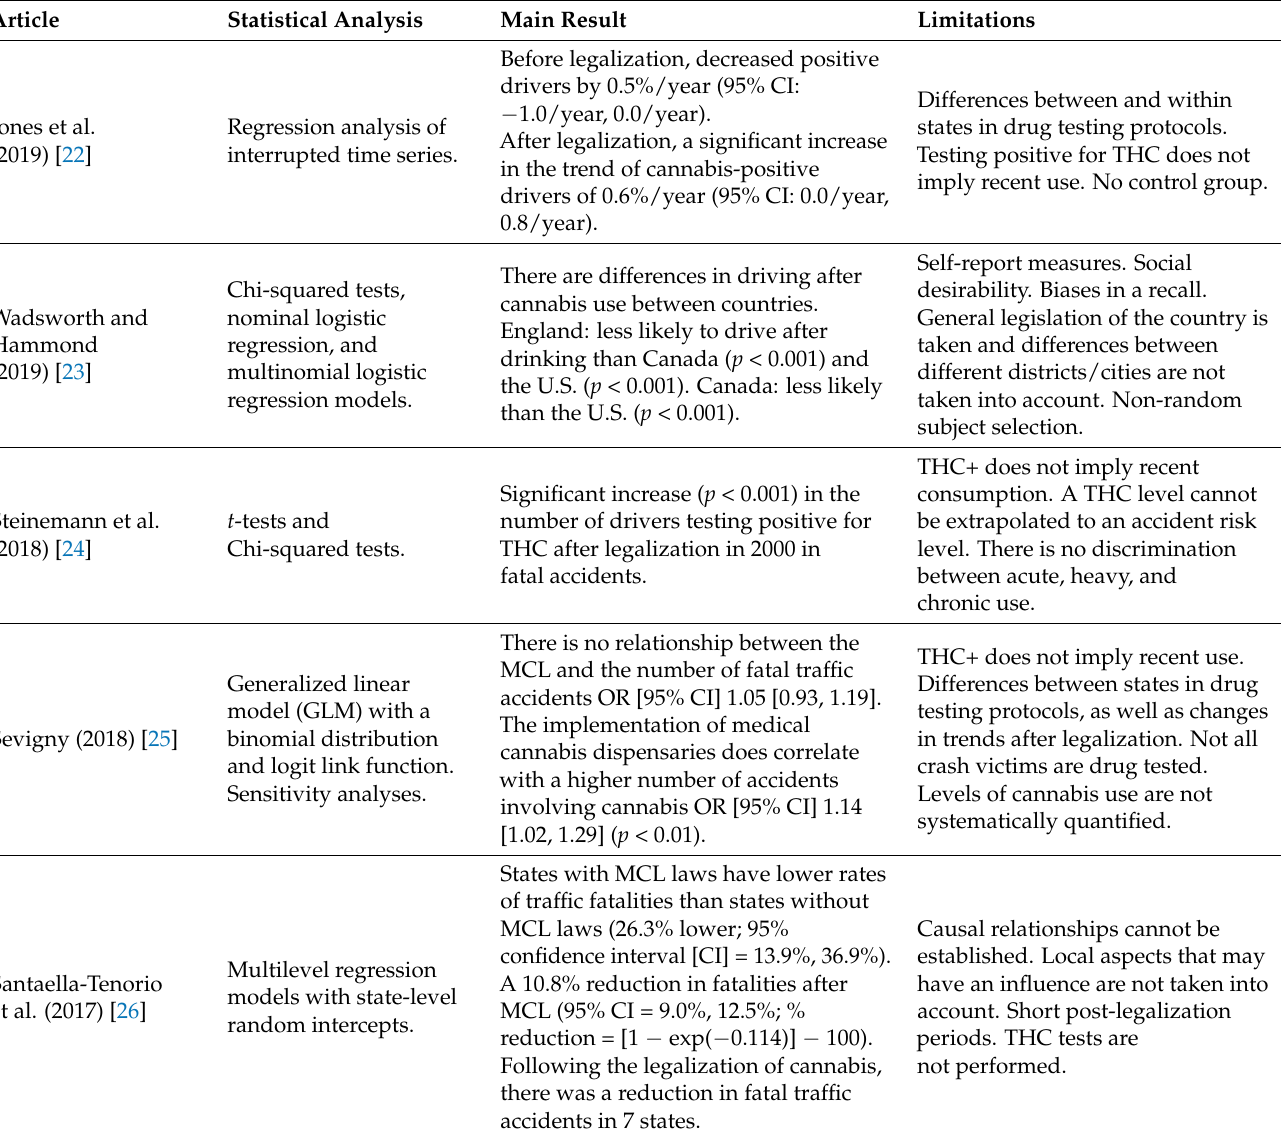
Table 2. Studies related to the legalization of medical cannabis: design, main results, and